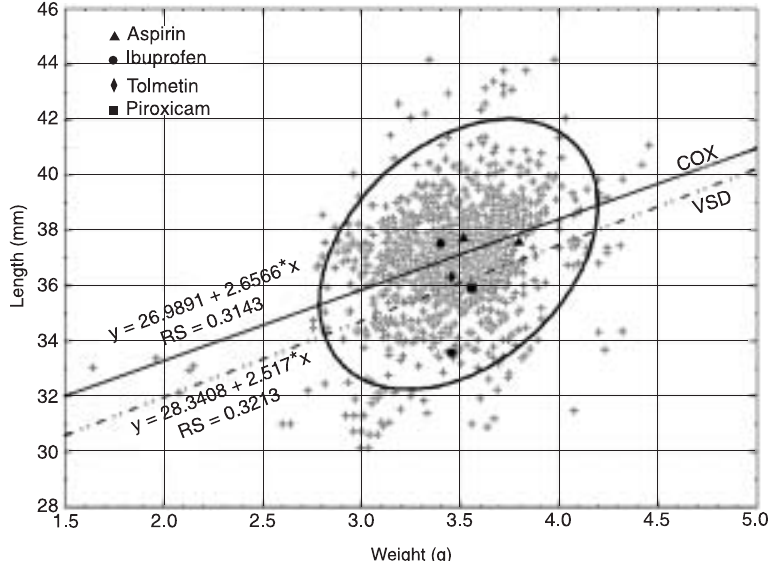
Figure 3. Correlation between fetal weight and length of rat fetuses prenatally exposed to cyclooxygenase (COX) inhibitors. Each symbol indicates a single fetus with a ventricular septal defect (VSD) exposed to the corresponding substance examined. Regression equa- tion and Spearman rank R (RS) for malformed and non-malformed offspring are presented on the corresponding regression line.